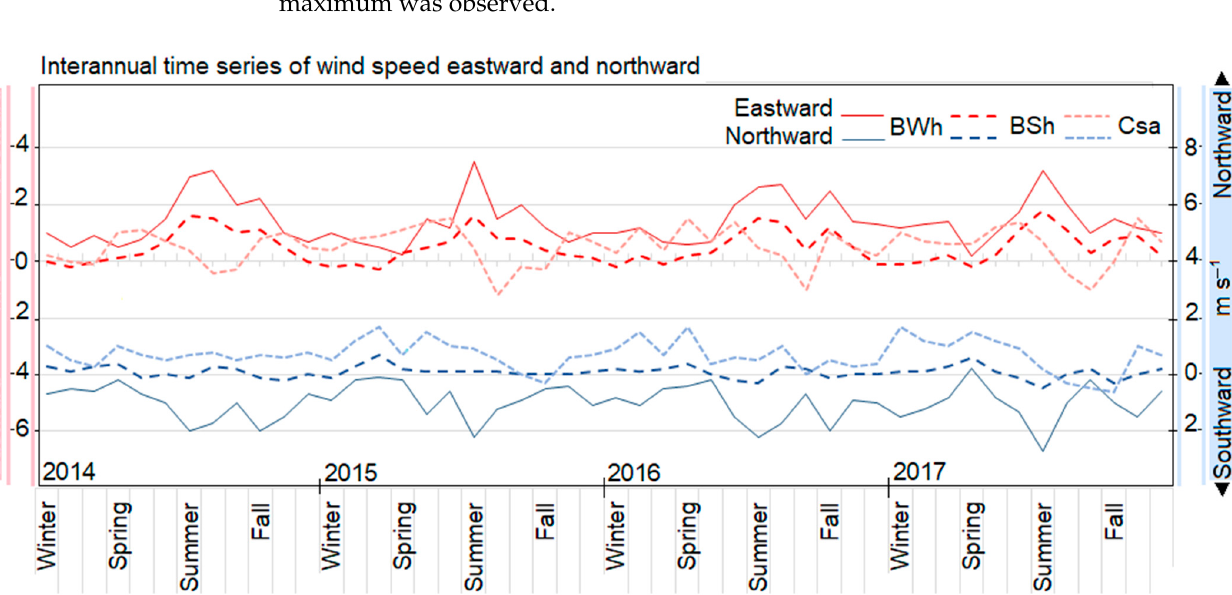
Figure 5. Histogram of wind speed (m s − 1 ) monthly averages for 2014–2017. From left to right: Vertical axis shows event frequencies and horizontal axis represents wind speed in BWh, Csa, and BSh.